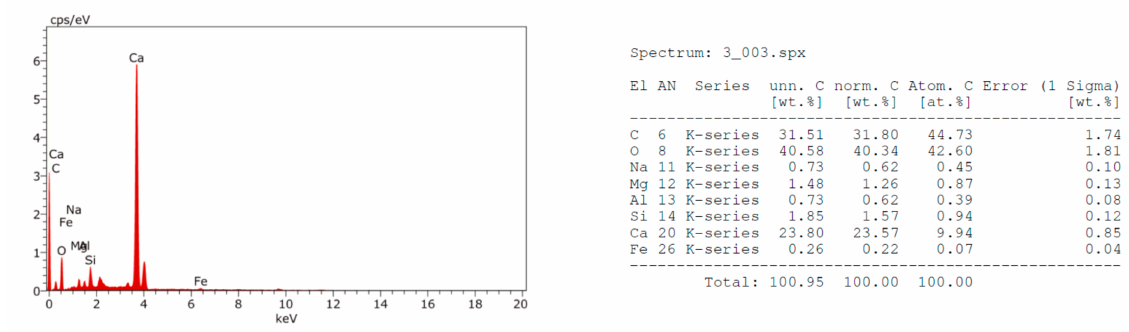
Figure 2. EDX analysis of Mix A fractured surface.